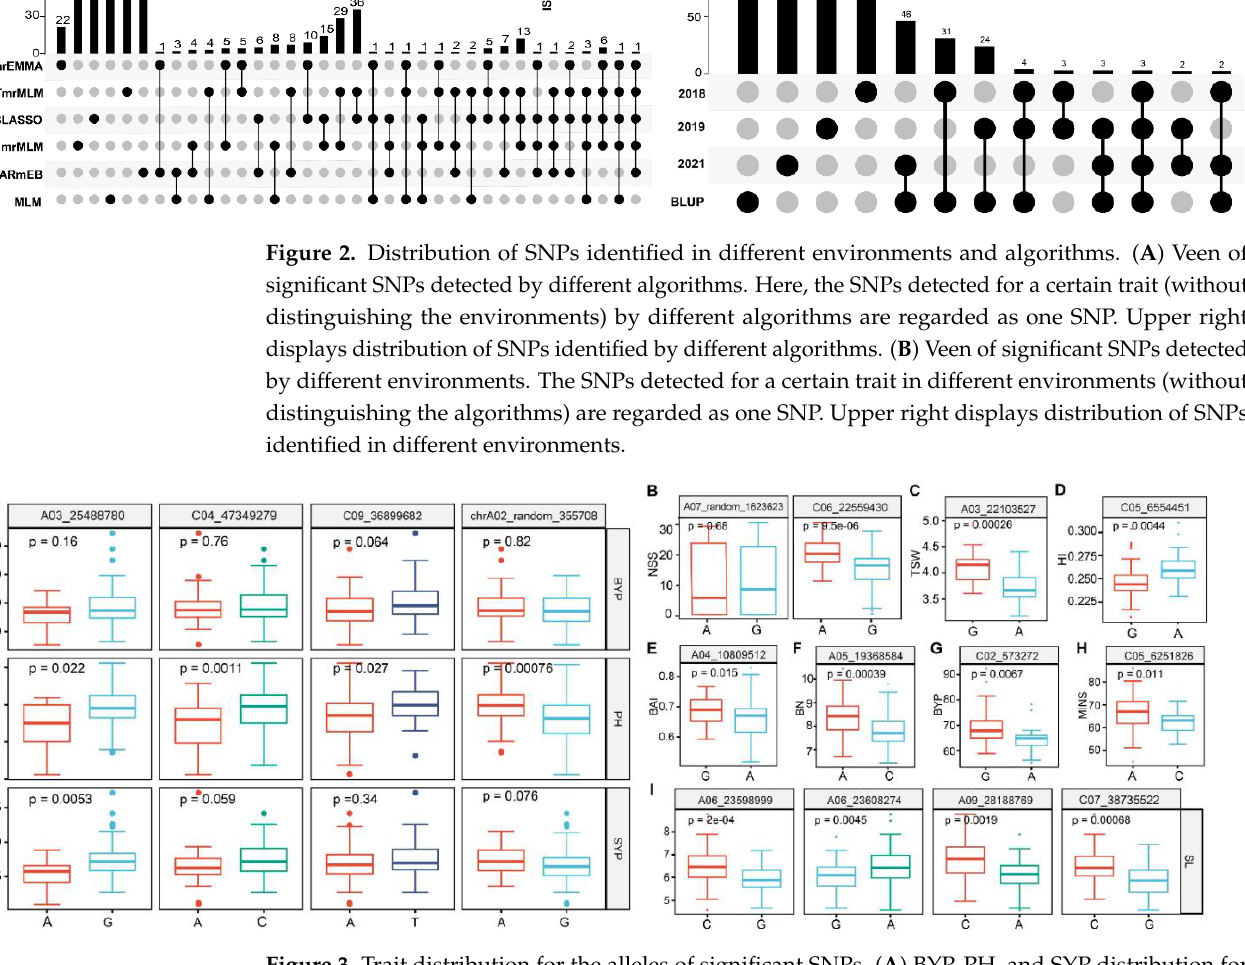
Figure 3. Trait distribution for the alleles of significant SNPs. ( A ) BYP, PH, and SYP distribution for the significant SNPs detected by PH. The horizontal line in the box plot shows the median value, and the upper and lower boxes represent the upper and lower quartiles of the data set. Statistical significance is determined by the Wilcoxon test. ( B – I ) show distributions for the alleles of stable